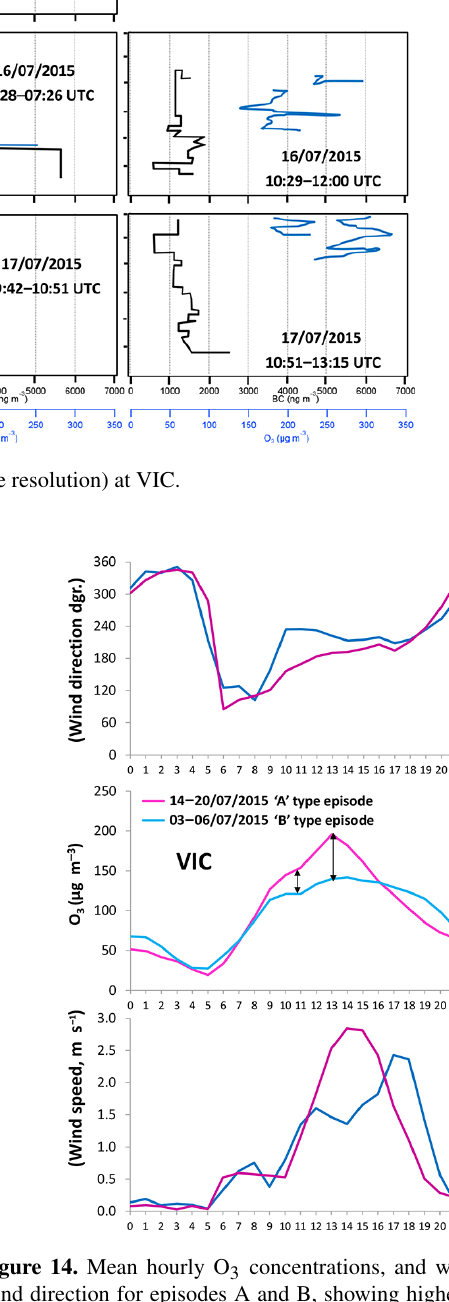
Figure 14. Mean hourly O 3 concentrations, and wind speed and wind direction for episodes A and B, showing higher levels in the A episodes for the two O 3